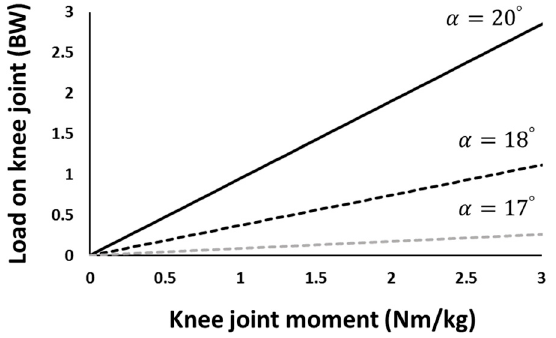
Figure 13. Change of the load on the prosthetic knee required for the stopper to remain at rest on the gear versus pressure angle ( α ). The black solid indicates α = 20 ◦ . The black and gray dashed lines indicate α = 18 ◦ and α = 17 ◦ , respectively.